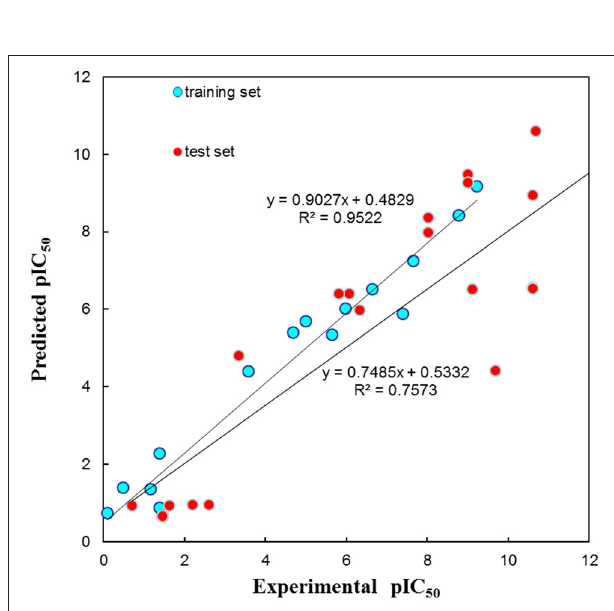
FIGURE 5 | The graph of experimental vs. predicted activities by Hypo